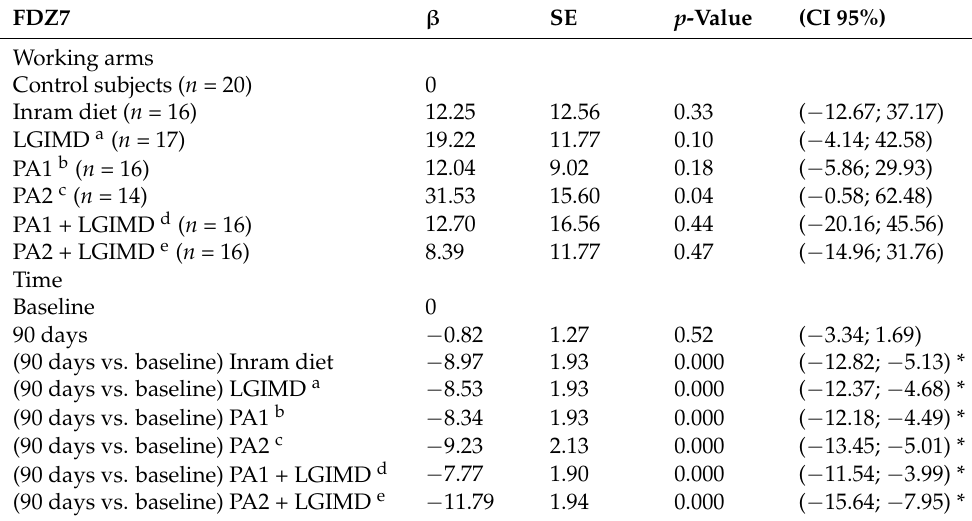
Table 4. Repeated measures analysis of variance. Effect of treatments on FZD7a expressions by